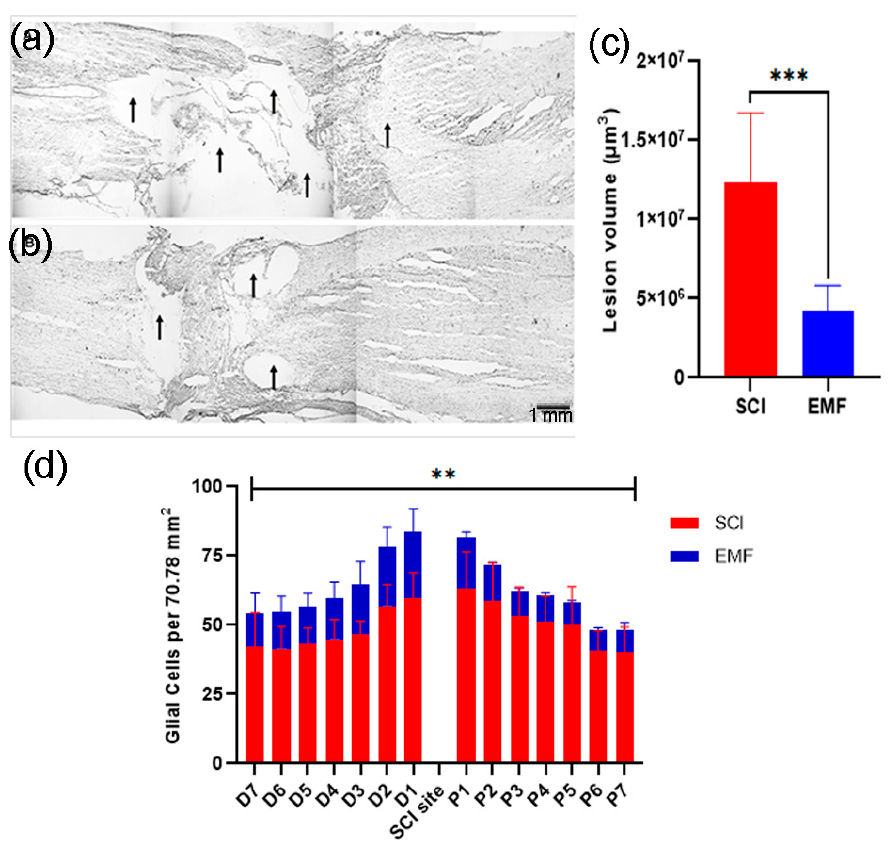
Figure 6. Neuroprotective effect of EMF after complete SCI. The representative spinal cord images of SCI ( a ) and EMF ( b ) groups. Scale bar = 1 mm. Arrows show the lesion cavity in both groups. Lesion volume shows a comparison between SCI ( n = 5) and EMF ( n = 6) groups of rats ( c ). The graph shows the number of glial cells per field at different locations from distal (D1–D7) to proximal (P1-P7) including injury in the six alternate longitudinal spinal cord sections of SCI ( n = 3) and EMF ( d ), n = 3. *** p < 0.001 indicates a comparison between SCI and SCI-treated EMF groups. A p < 0.01 (**) indicates a glia cell comparison between the SCI and SCI-treated EMF groups at all points (proximal-distal).